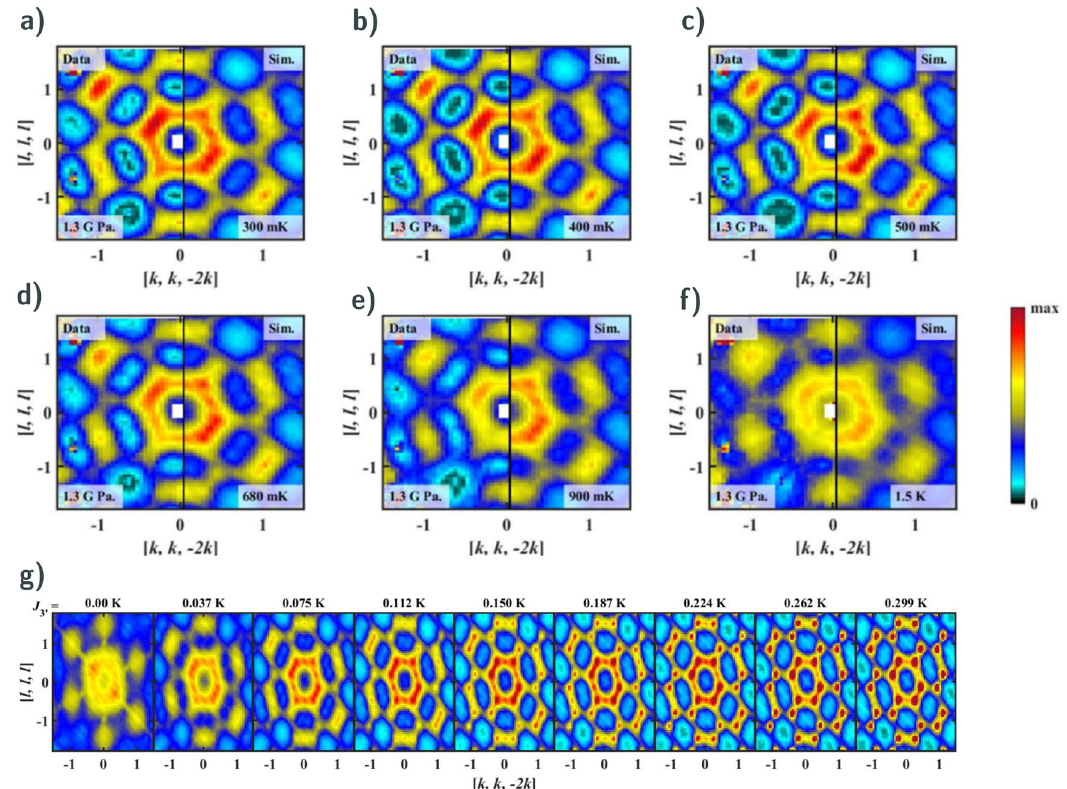
Fig. 4 Validation over temperature dependence and prediction of scattering data. Two-dimensional slices of [ l , l , l ] − [ k , k , − 2 k ] at six temperatures: ( a ) 300 mK, ( b ) 400 mK, ( c ) 500 mK, ( d ) 680 mK, ( e ) 900 mK and ( f ) 1.5 K. Each panel is a side by side comparison of experiment (left) and simulation (right). All the experimental data shown here are collected at 1.3 GPa. The parameters for the simulations are J 1 = 3.3(3) K, J 2 = − 0.079(8) K, J = 0.010(4) K, J 0 = 0.075(5) K and D = 1.3224(1) K. g The evolution of calculated S sim ð Q Þ as a function of J 0 3 3 parameters at J 1 = 3.33 K, J 2 = − 0.05 K, J 3 = 0 K and D = 1.3224